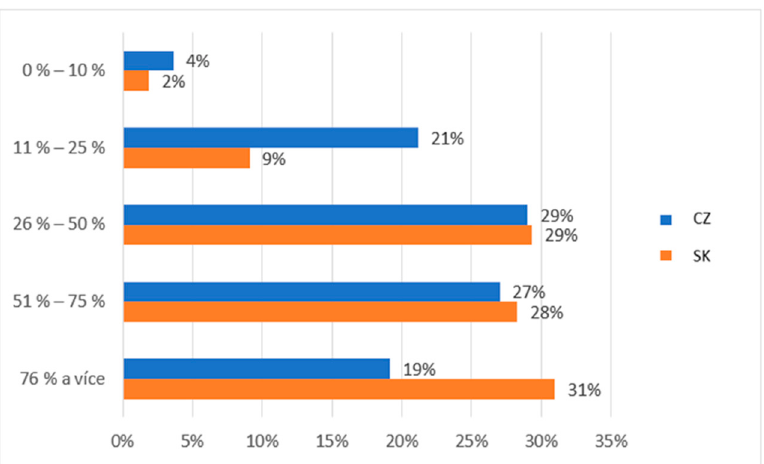
Figure 1. Descriptive statistics of the participants’ subjective needs of social and pastoral service (comparison of the healthy population of eastern Slovakia and north-western Czech Republic). Legend: CZ—healthy population of north-western Czech Republic, SK—healthy population of eastern Slovakia. Source: own resource.